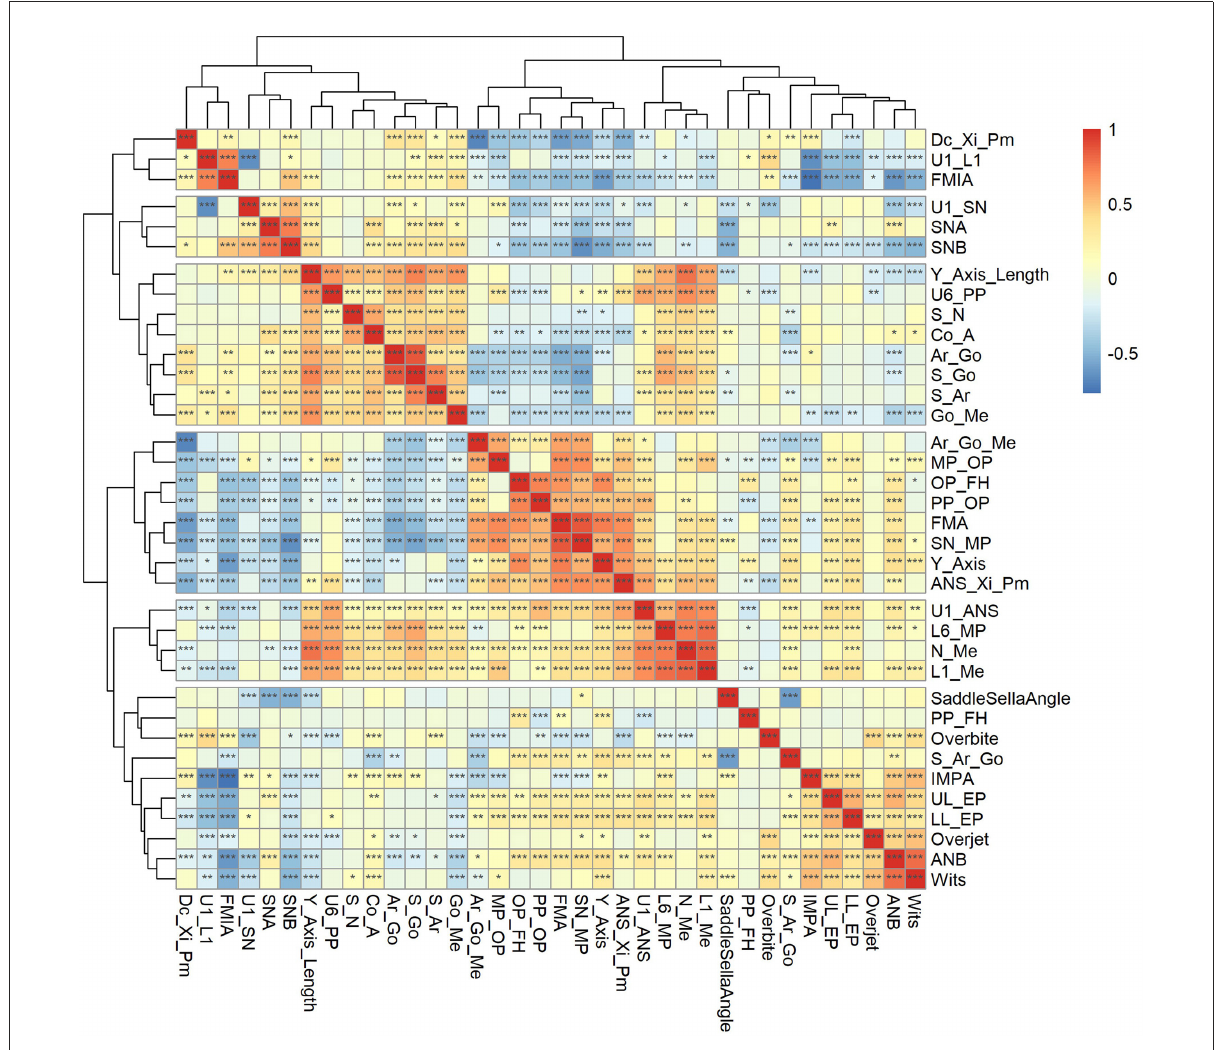
FIGURE2 Pearson’s correlation coefficient heat map and hierarchical clustering dendrogram for cephalometric variables. * P < 0.05, ** P < 0.01, *** P < 0.001.